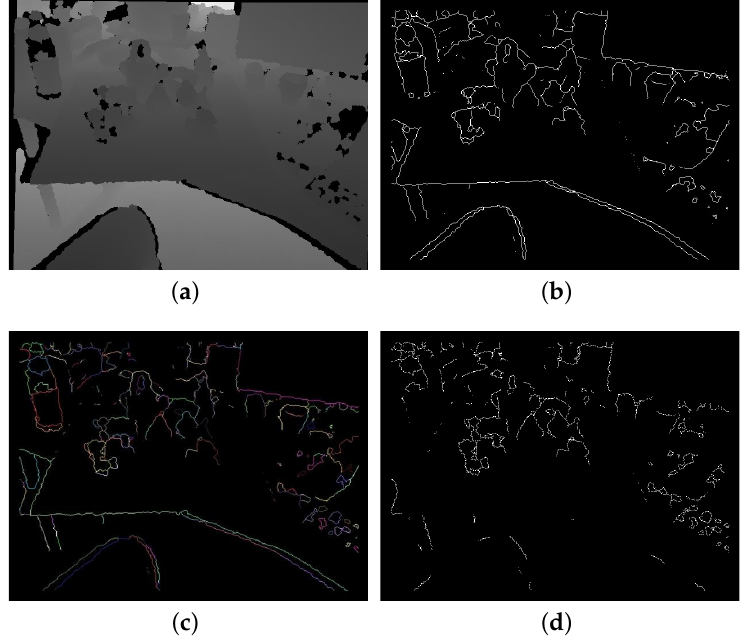
Figure 3. Example of boundary estimation and clustering ( a ) depth image; ( b ) estimated boundary pixels; ( c ) continuous boundary pixels are clustered into curves. The pixels belonging to the same curve have the same color; and ( d ) the boundary pixels after removing long